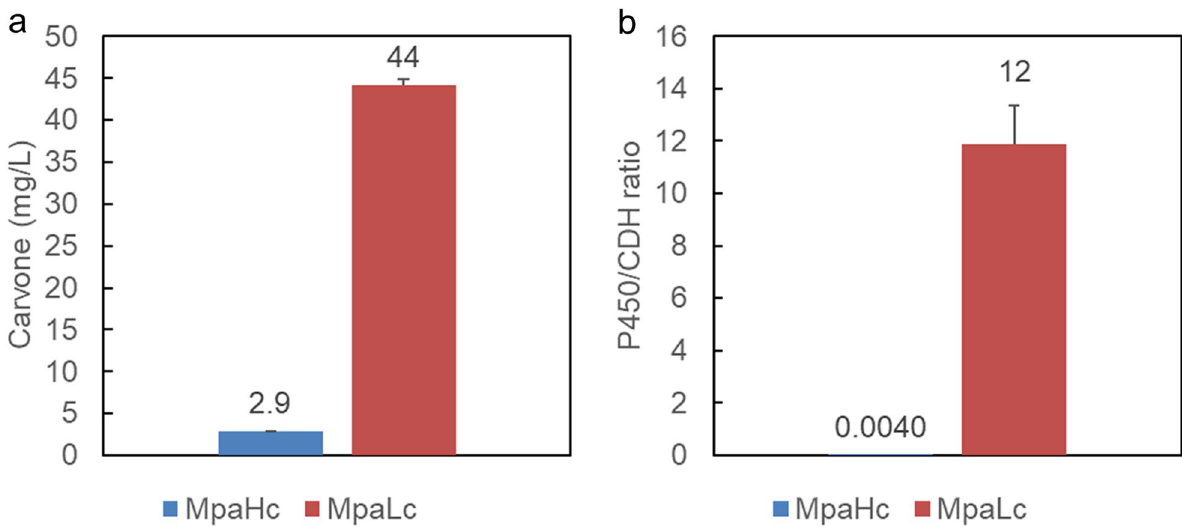
Figure 7. Carvone conversion via a single strain reaction. ( a ) The novel strain MpaLc (BL21(DE3) pCDF- CYP71D18-ATR2, pMW-ISPD), and the previously constructed strain MpaHc (BL21(DE3) pCDF-CYP71D18- ATR2, pET-ISPD) were analyzed using the carvone biocatalysis assay with 100 mg/L (−)-limonene as a starting substrate. Error bars represent standard deviations of n = 3. ( b ) The P450/CDH ratio was calculated based on quantification concatamer (QconCAT) proteome analysis of MpaHc and MpaLc strains. Error bars represent standard deviations of n =